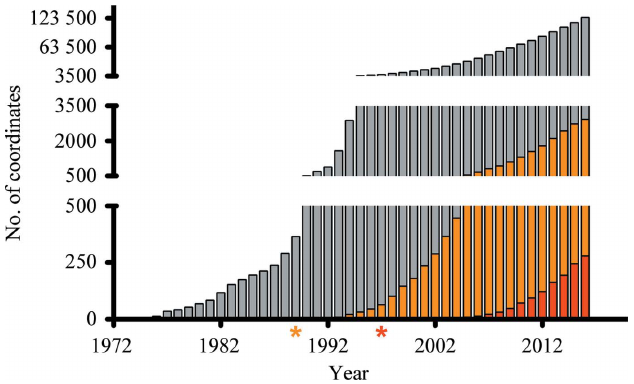
Figure 1 The accumulation of deposited coordinates in the Protein Data Bank. The total numbers of deposited coordinates per year are shown as grey bars. The counterparts for all membrane proteins and human membrane proteins are shown as orange and red bars, respectively. The asterisks show the year of the first structure deposition of a membrane protein (orange) and a human membrane protein (red). In the decade after the first structure, the number of deposited coordinates of membrane proteins grew in an exponential manner. This exponential growth implies the contribution of technical breakthroughs such as the usage of recombinant DNA for protein production in the case of soluble proteins in the early